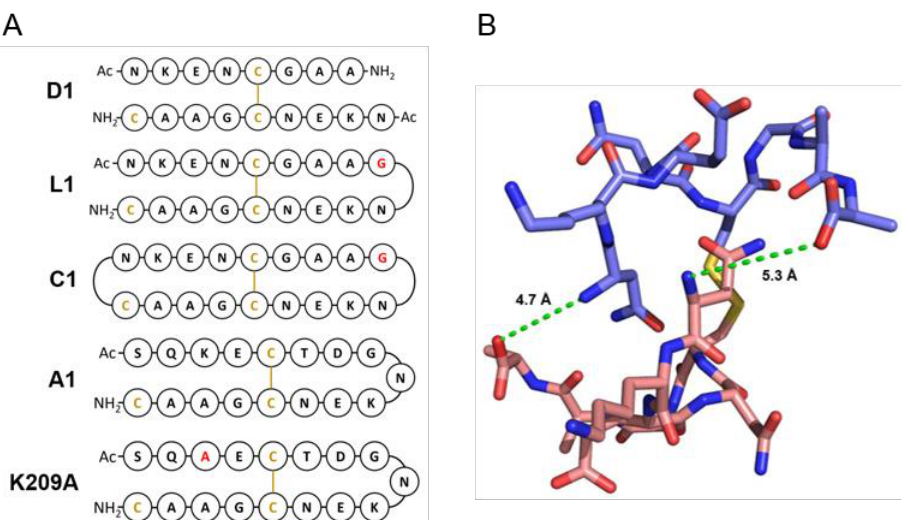
Figure 2. ( A ) Schematic representation of dimeric 4D11 epitope peptides: dimer—D1, linear—L1, backbone cyclised—C1, wild-type sequence 17-residue peptide—A1 and its single point mutant— K209A, which has had the residue Lys209, which is important for 9H4 binding, replaced with alanine. ( B ) Crystal structure of 4D11-bound homodimer peptide (PDB ID: 5TBD) shows close proximity between the N- and C-termini of the peptides; green dashed lines indicate distance between the peptide termini.